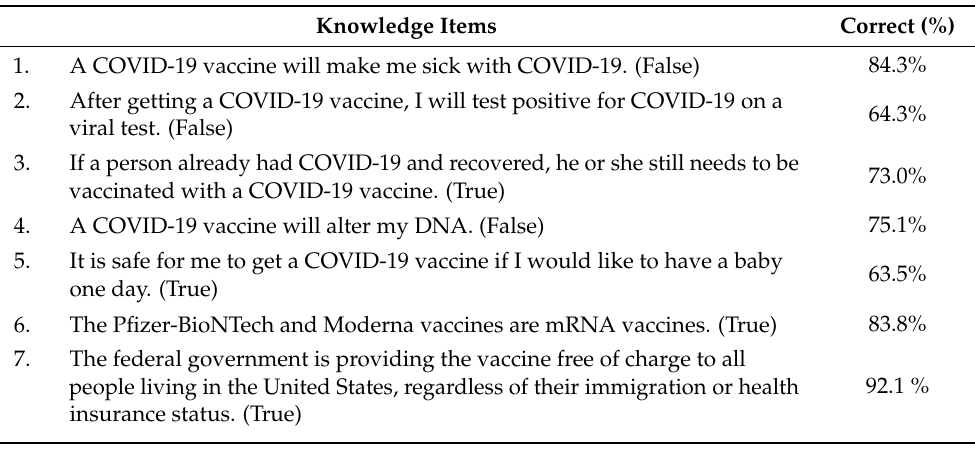
Table 3. Knowledge about COVID-19 vaccine among Chinese-Americans ( n =